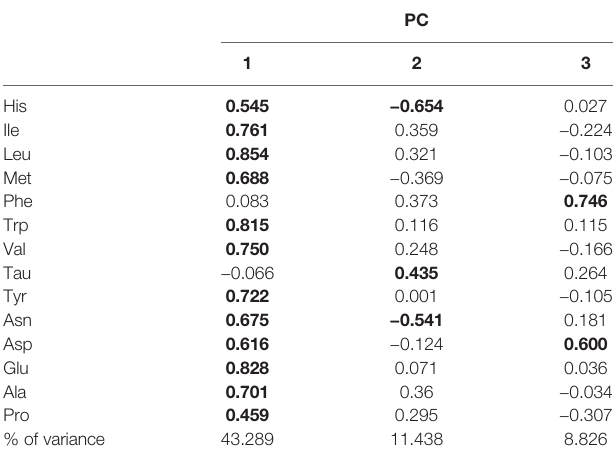
TABLE 4 | The result from principal component analysis exploring amino acid pro fi les.